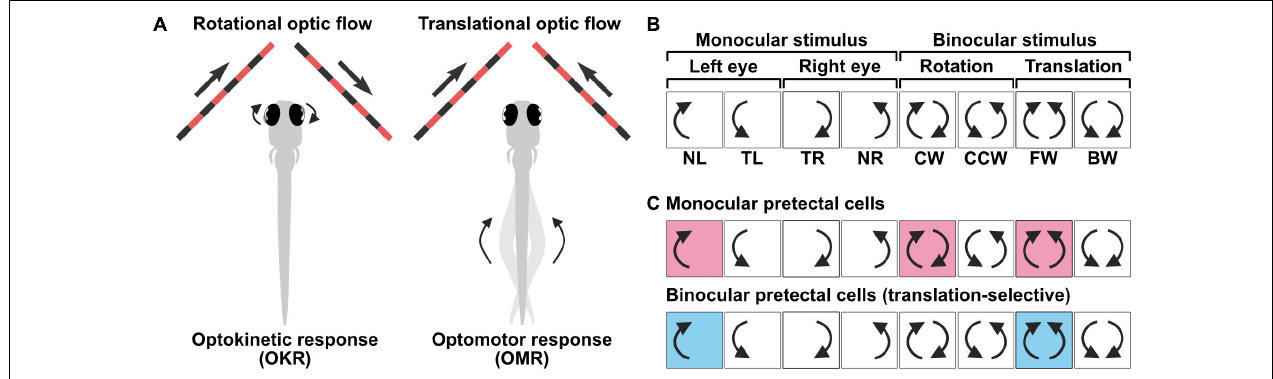
FIGURE 2 | Representation of binocular optic flow information by pretectal neurons. (A) Rotational and translational optic flow trigger optokinetic response (OKR) and optomotor response (OMR), respectively. (B) 8-phase visual stimulus protocol used to characterize monocular and binocular selectivity of pretectal neurons. NL, nasalward motion to left eye; TL, temporalward motion to left eye; TR, temporalward motion to right eye; NR, nasalward motion to right eye; CW, clockwise; CCW, counter-clockwise; FW, forward; BW, backward. (C) (Top) Monocular direction selective pretectal cells respond to motion that moves in one direction (either nasal or temporal) presented to one eye. This example cell responds whenever a nasal motion is presented to the left eye, irrespective of the motion presented to the right eye. (Bottom) Translation-selective cells that responds to forward translational motion but no to rotational motion. In contrast to the cell shown above, the response to clockwise motion is suppressed although its response is predicted from the activity of this cell responding to nasal motion in the left